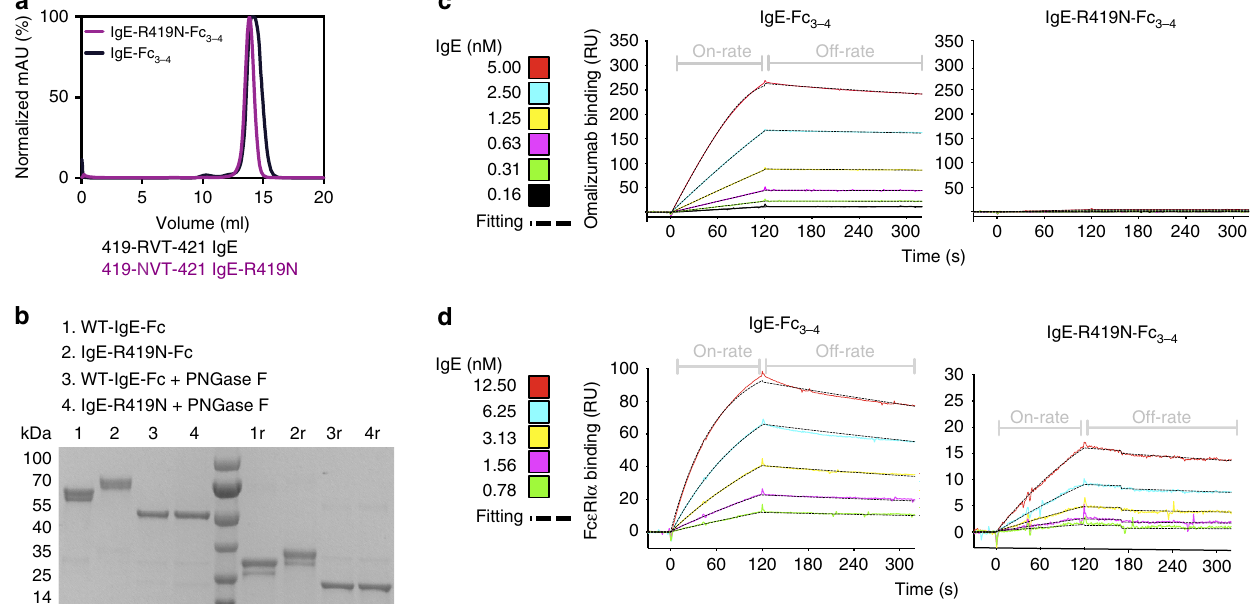
Figure 5 | A single IgE mutation prevents omalizumab binding. ( a ) The IgE-Fc 3–4 point mutant, R419N, contains a novel glycosylation consensus sequence and is expressed as a soluble monomer as assessed by gel filtration chromatography of IgE-R419N-Fc 3–4 and IgE-Fc 3–4 species. ( b ) SDS–PAGE analysis of non-reduced and reduced (‘r’) IgE-R419N-Fc 3–4 , and IgE-Fc 3–4 , demonstrates that the R419N mutation induces an additional glycosylation event and a mass shift of B 2kDa per IgE chain. PNGaseF treatment removes all N -linked glycans, and demonstrates that the mass shift in the IgE-R419N-Fc 3–4 protein arises from N- linked glycosylation. ( c , d ) SPR-binding assays with immobilized omalizumab ( c ) or Fc e RI a ( d ) show that IgE-R419N-Fc 3–4 is unable to bind omalizumab, but exhibits binding to Fc e RI a at nM